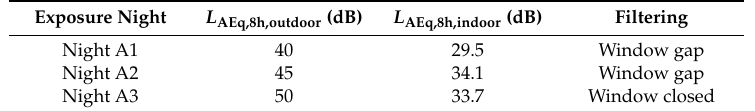
Table 1. Simulated outdoor and indoor sound pressure levels and frequency filtering used in exposure Nights A1, A2 and A3 in Study A.